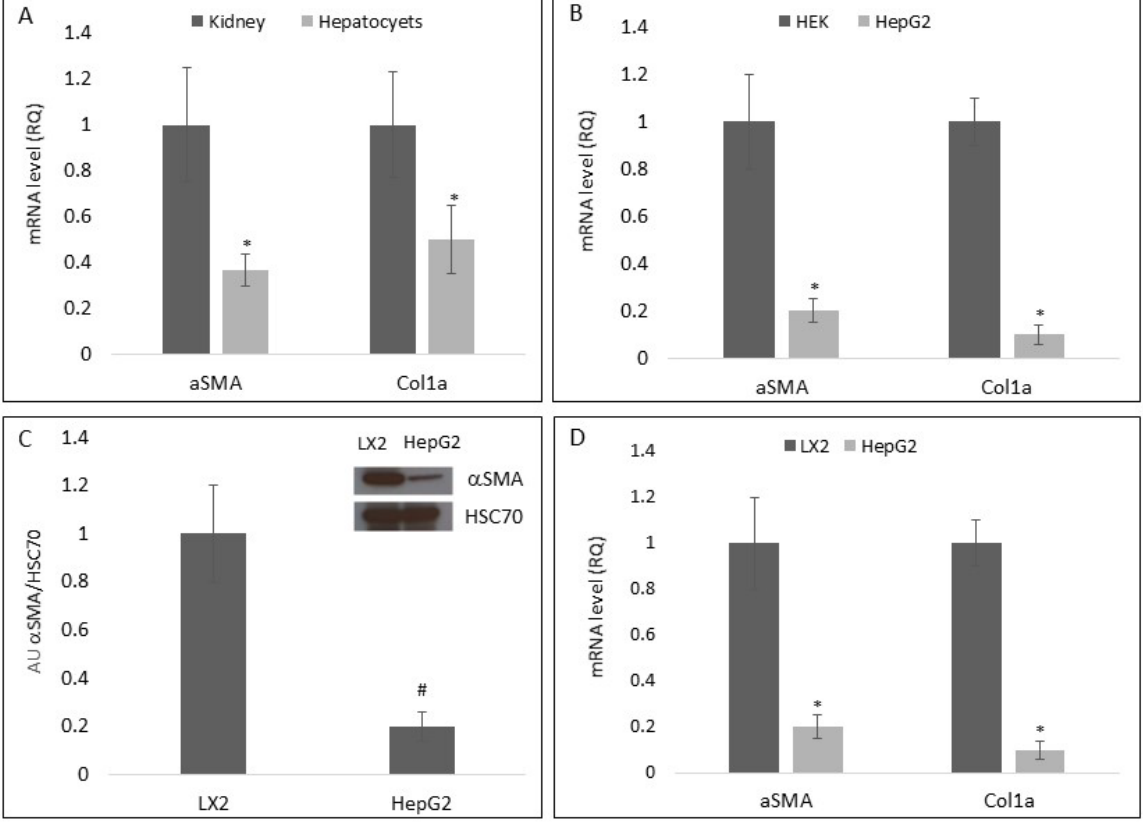
Figure 1. Effect of primed medium on pHSCs differentiations markers. Primary hepatocytes and HepG2 and LX2 cell lines were cultured for 5 days. The primed medium was collected and placed over pHSCs for 24 h. Primed medium from primary mice kidney cell cultures or HEK cell line were used as a control group. Following incubation, pHSCs were harvested and the mRNA or protein levels of α SMA and Col1a were examined. ( A ) The effect of hepatocyte-primed medium on α SMA and Col1a mRNA levels in pHSCs. ( B ) The effect of HepG2 cell-primed medium on α SMA and Col1a mRNA levels in pHSCs. ( C ) The effect of HepG2 and LX2 cell-primed medium on α SMA protein levels in pHSCs. ( D ) The effect of HepG2 and LX2 cell-primed medium on α SMA and Col1a mRNA levels in pHSCs. * Significantly lower than the kidney, HEK or LX2 cells p < 0.0001; # Significantly lower than LX2 cells, p < 0.008. ANOVA with a post-hoc Bonferroni-adjusted Student’s t -test. To confirm that the effect of the pellet on pHSC fibrosis markers was mediated by EVs, LX2 and HepG2 cell lines were cultured in the presence of 20 µ M GW4869, an established inhibitor of exosome biogenesis/release [13]. pHSCs incubated with EV-free LX2-primed medium showed α SMA mRNA levels similar to those measured in pHSCs incubated with LX2-primed medium containing EVs (Figure 3A). In contrast, α SMA mRNA levels in pHSCs incubated with EVs-free HepG2-primed medium were significantly higher relative to their levels in pHSCs incubated with HepG2-primed medium containing EVs (Figure